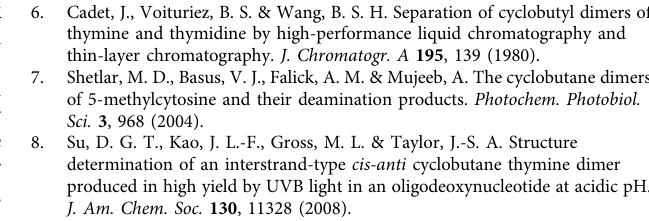
Fig. 1 Structure of the four diastereomers of the cyclobutane thymine dimer. Cis (endo) and trans (exo) stereomers; syn (head-to-head) and anti (head- to-tail) regioisomers Trans - syn and cis - anti thymine dimers exist as enantiomeric